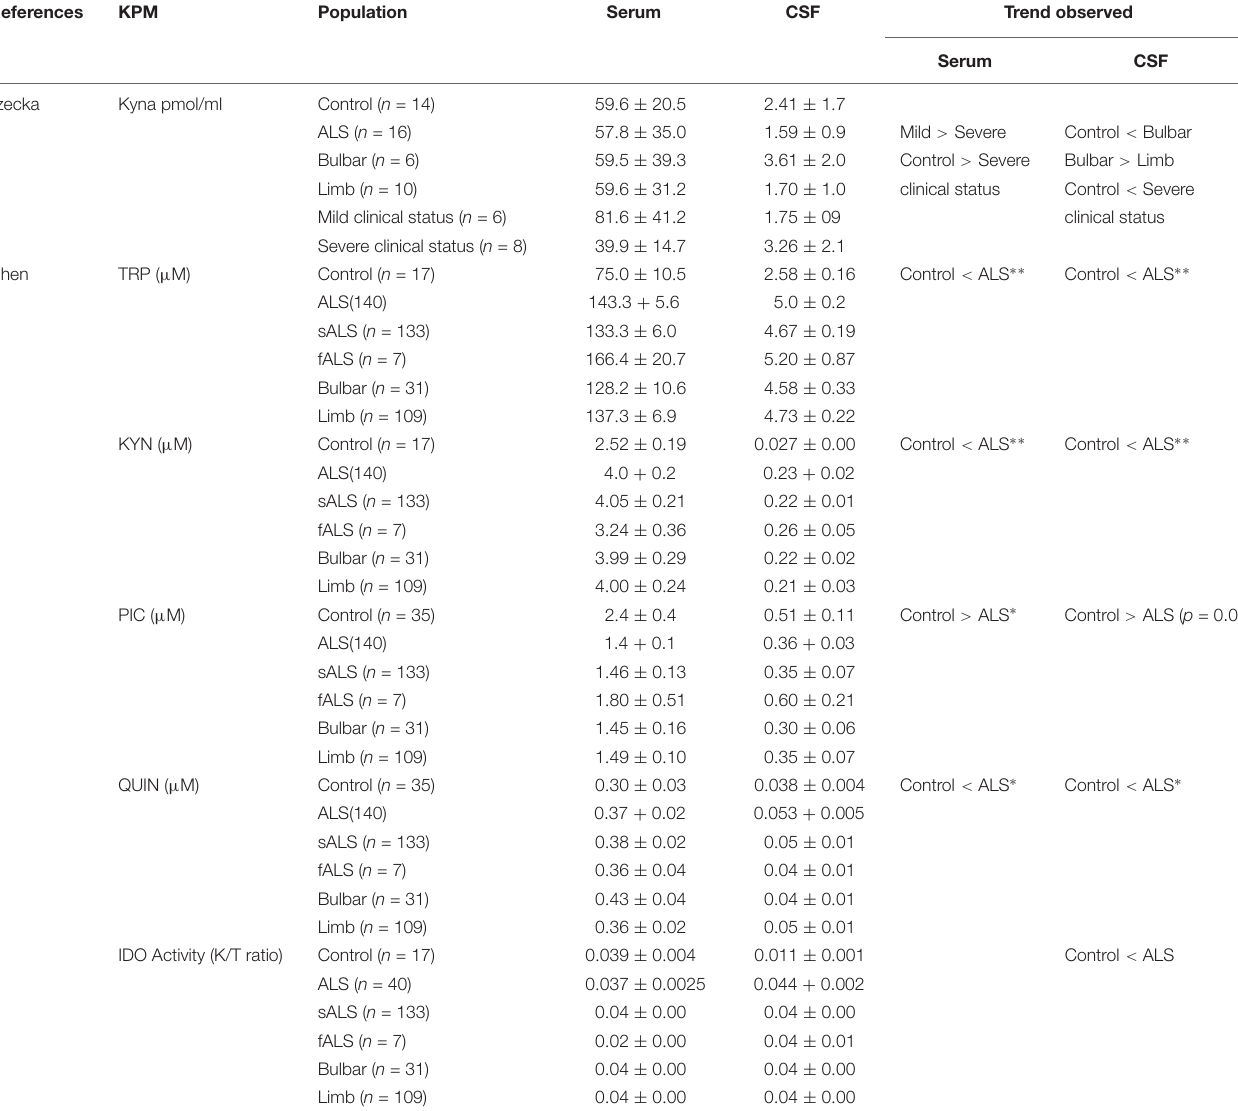
TABLE 1 | Summary of Kynurenine Pathway metabolite levels in controls and ALS patients collated from Ilzecka and